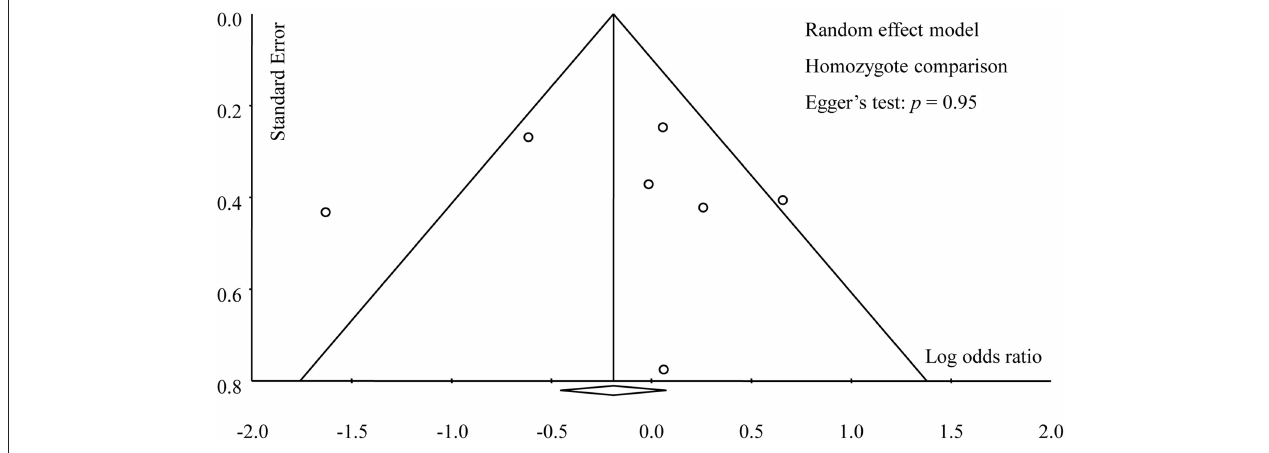
FIGURE 5 | Funnel plot of overall analysis in homozygote